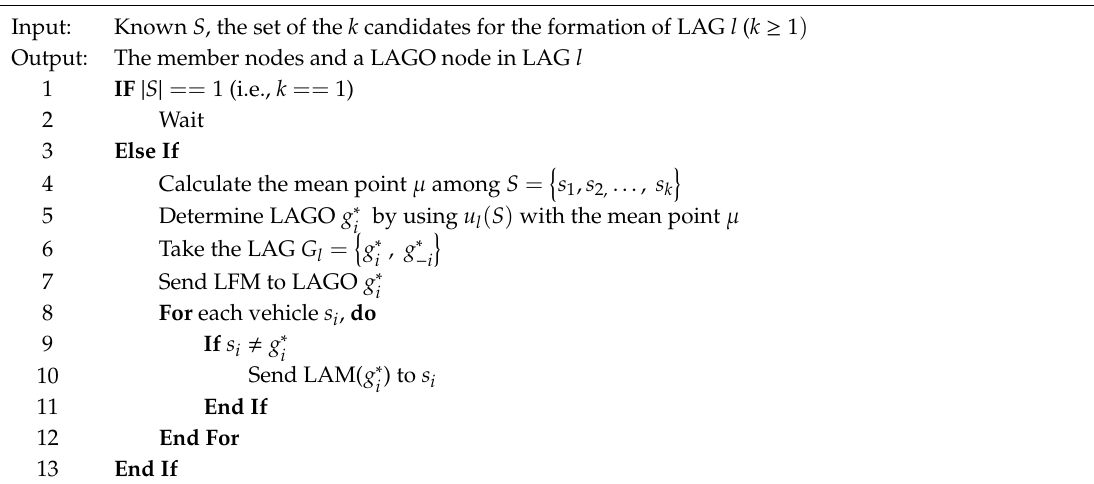
Algorithm 1: New LAG Formation and LAGO